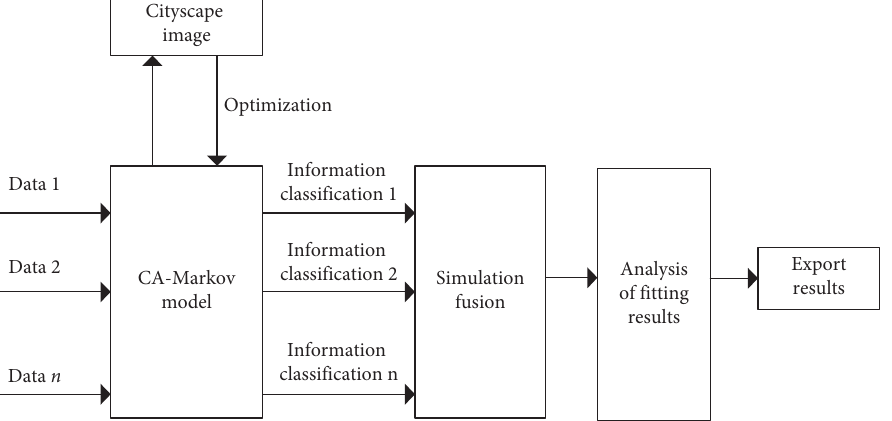
Figure 3: Schematic diagram of CA-Markov model.